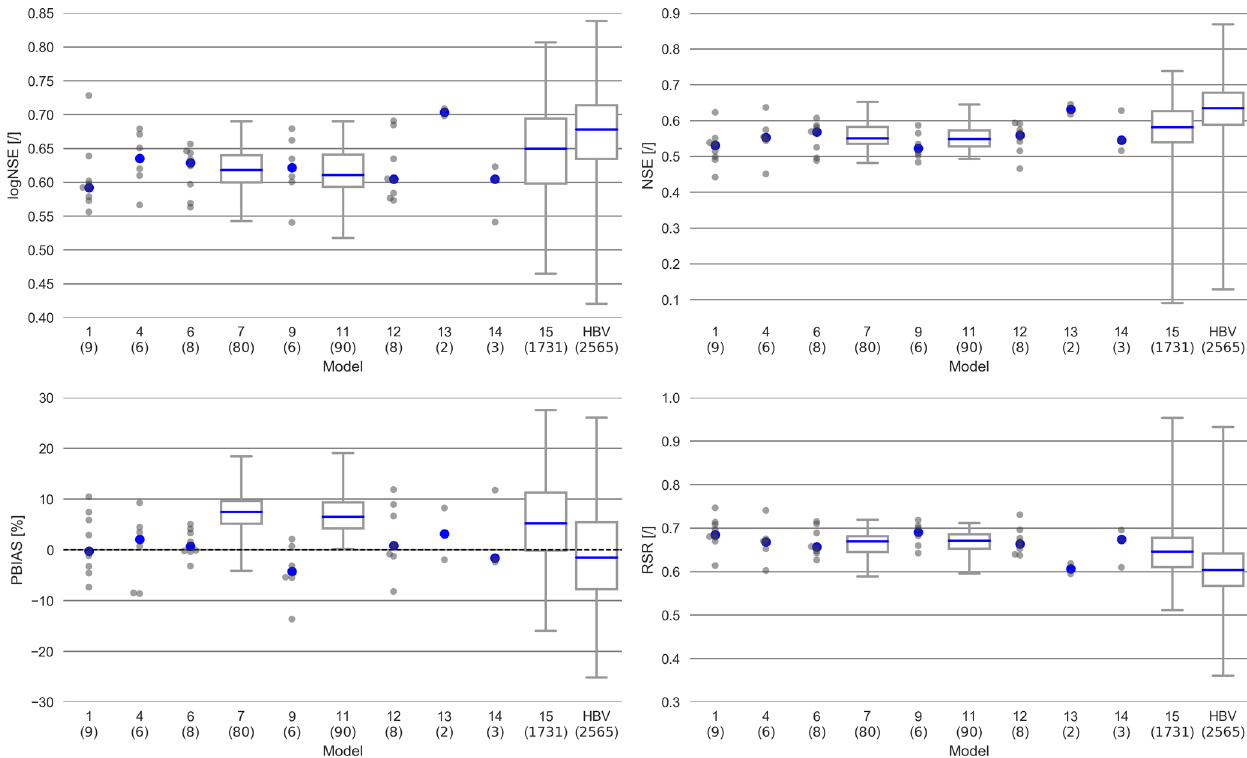
Figure 6. Distribution of the values of the behavioral runs in the validation period. Plotted as a box plot if the number of behavioral runs is above 10. Number of behavioral runs are in brackets under the name of the model. Blue dot or line marks the